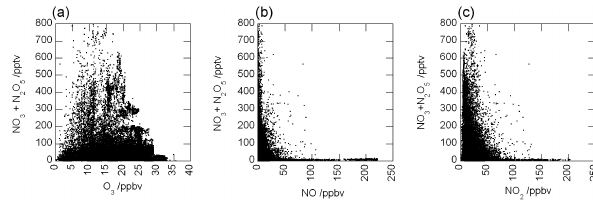
Fig. 8. Scatter plots showing correlation of mixing ratios of NO 3 +N 2 O 5 against (a) O 3 , (b) NO and (c) NO 2 for all night-time data. Data for species on horizontal axis was interpolated (within 10 minutes where available, otherwise not shown) onto same time-grid as NO 3 +N 2 O 5 .